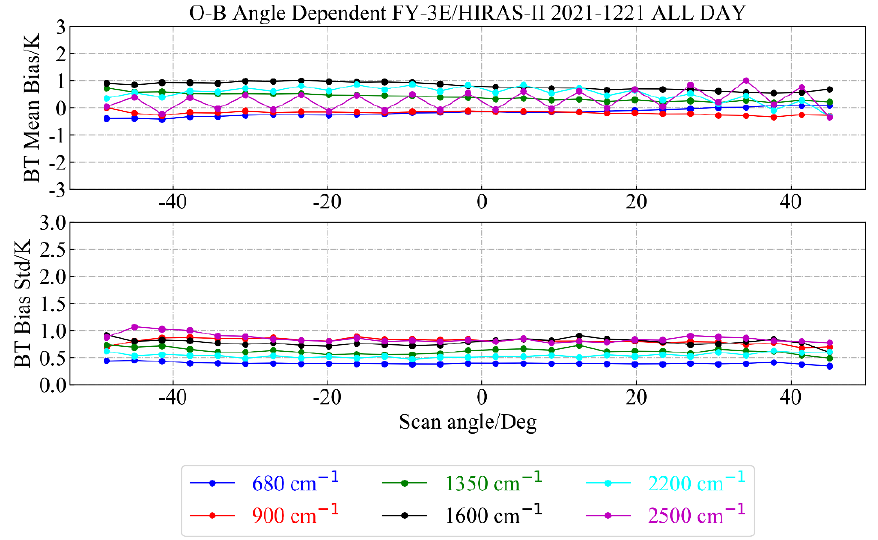
Figure 13. The distribution of the bias of a typical channel with the scanning angle.